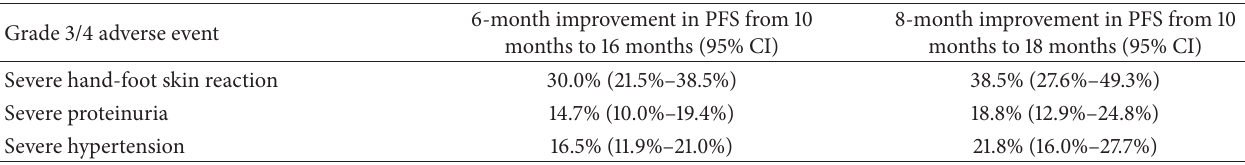
Table 4: Maximum acceptable